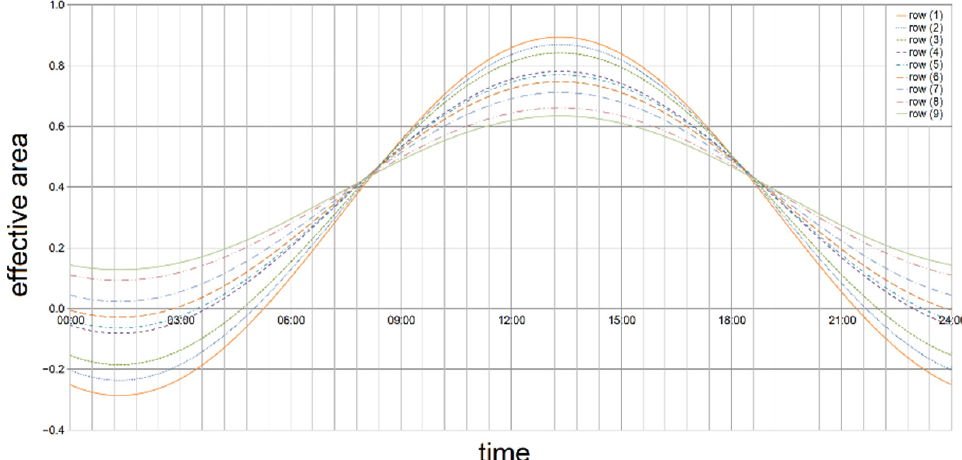
Figure 8. Effective area for ψ = 180°.